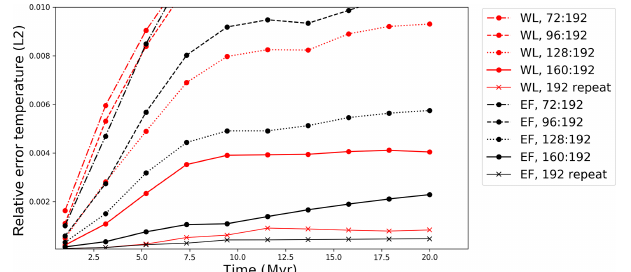
Figure 13. Convergence of models with varying resolution. Vertical axis shows the relative error ( L 2 ) of the temperature field. We have truncated the vertical axis so as to focus on trends in the higher- resolution results. The error value is based on the error between the highest-resolution model (192 elements in the vertical axis) and each of the models with lower resolution, as labelled in the figure. Experiments were repeated at the highest resolution to provide a baseline for model reproducibility (labelled